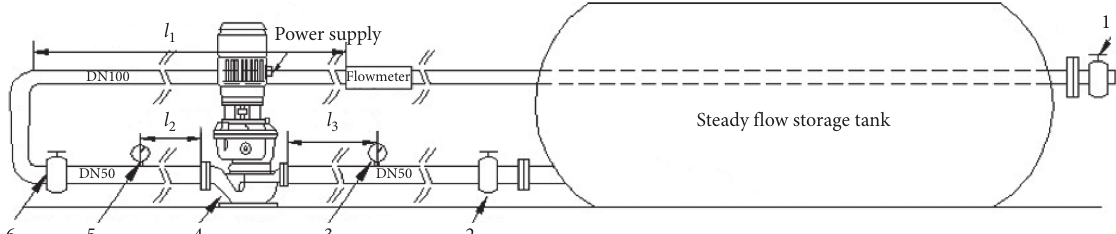
Figure 17: Piping diagram of the experimental platform.1, inlet control valve; 2, outlet control valve; 3, outlet pressure gauge; 4, high-speed partial emission pump; 5, inlet pressure gauge; 6, flow valve.